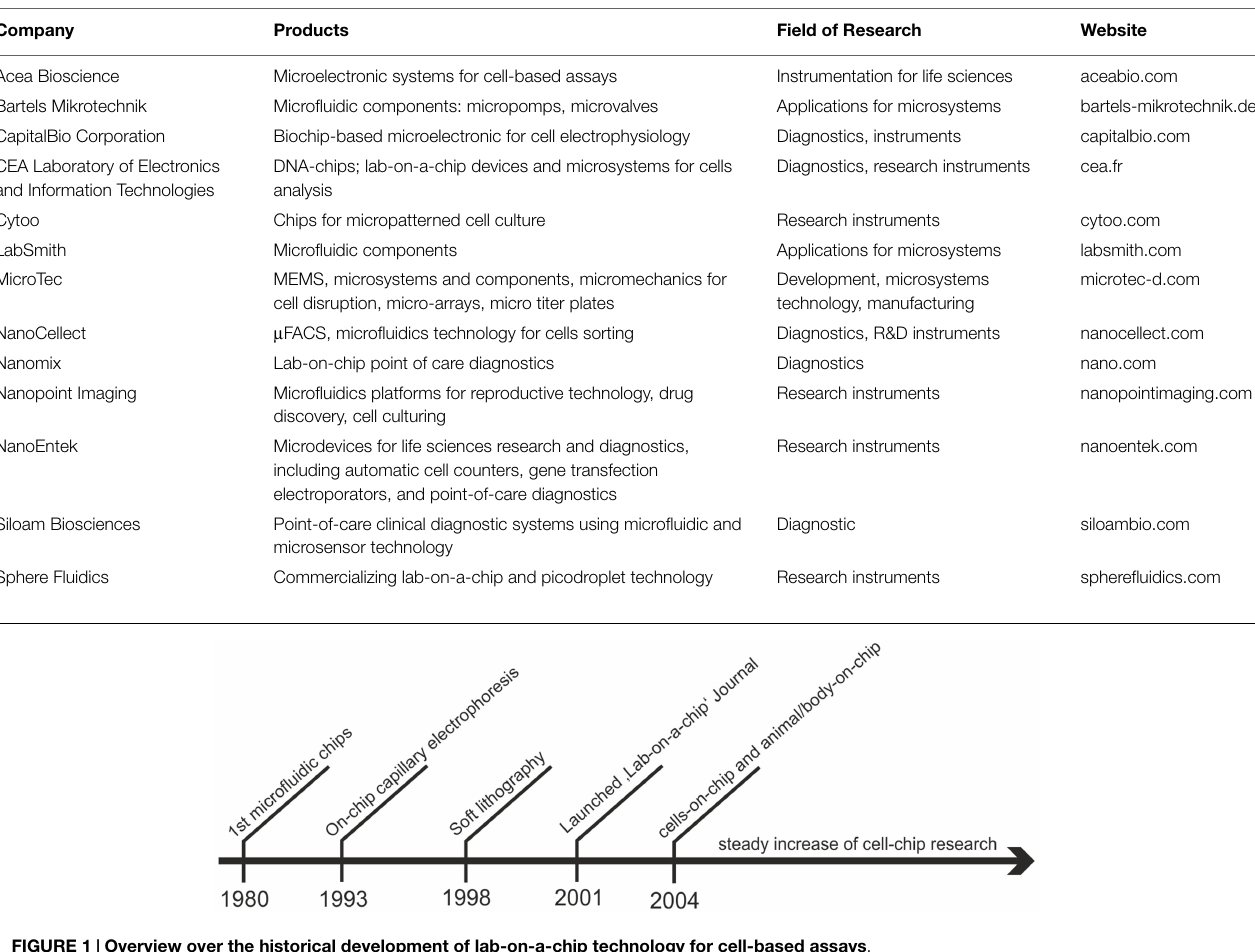
FIGURE 1 | Overview over the historical development of lab-on-a-chip technology for cell-based assays .